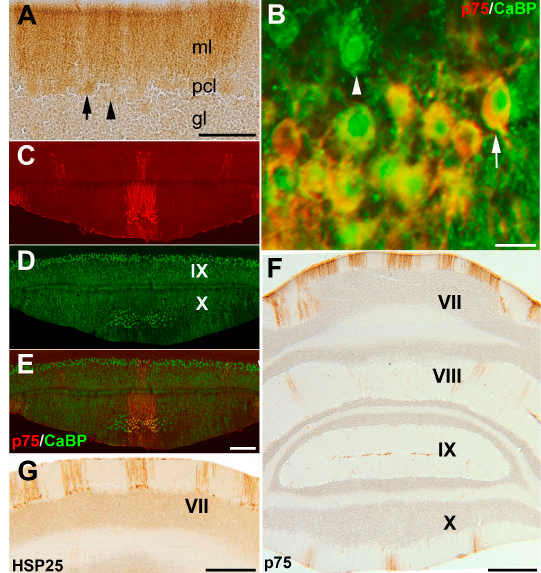
Figure 1. Frontal sections of an adult mouse cerebellum immunostained with p75NTR, CaBP and HSP25 at P28. The lobules are shown by Roman numerals. ( A , B ) The cerebellar cortex immunoperoxidase stained by p75NTR shows that the Pc somata in the Purkinje cell layer and dendrites in the molecular layer are immunoreactive (arrow; black in A, and white in B). Some Pc somata expressing p75NTR are weak (A, arrowhead) or absent (B, arrowhead); ( C – E ) Double immunostaining of a frontal section at lobule IX and X using p75NTR (red) and CaBP (green). Stripes of immunoreactive Pcs are clear in the vermis; ( F ) Immunostaining of a frontal section at the cerebellum using p75NTR. Immunoreactivity is not present in the AZ and PZ. Stripes of immunoreactive Pcs are clear in the vermis of the CZ (VII) and NZ (X); ( G ) Immunostaining of a frontal section through the lobule VII using HSP25. Stripes of immunoreactive Pcs are clear in the vermis of the CZ. Abbreviations: ml, molecular layer; Pcl, Purkinje cell layer; gl, granular layer.Scale bars: A = 100 µm; B = 20 µm; E = 250 µm (applies to C – E ); F = 500 µm; G = 250 µm.